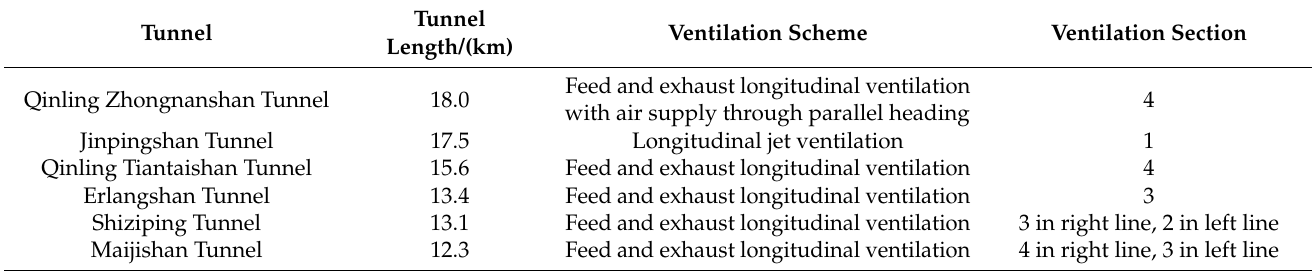
Table 1. Ventilation schemes of extra-long highway tunnels in